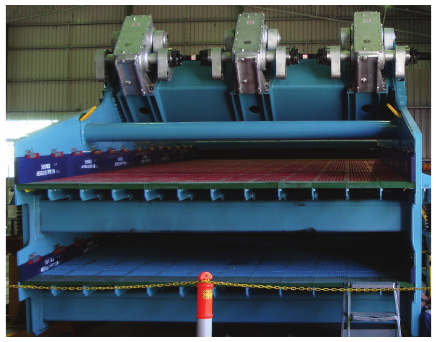
Figure 5: Simulated vibrating screen, front view.